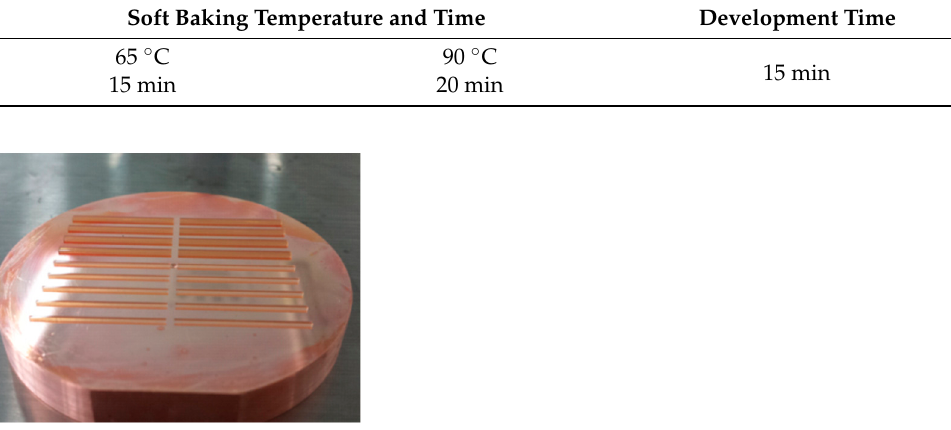
Figure 7. Optical microscope photograph of 18 SU ‐ 8 molds with optimum parameters on a copper disc: 8 SU ‐ 8 molds above for WR2.8 and 10 molds below for WR1.5.